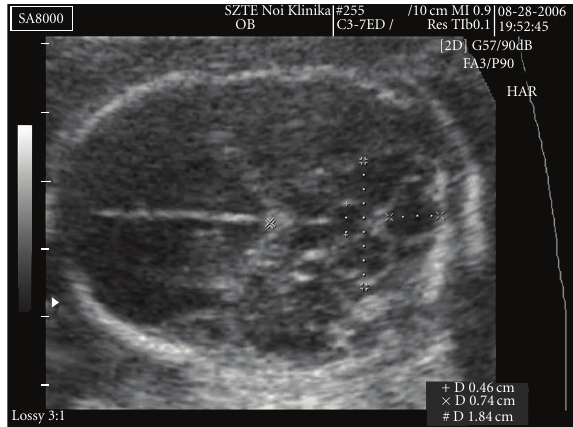
Figure 4: Cystic dilation of the aqueductus